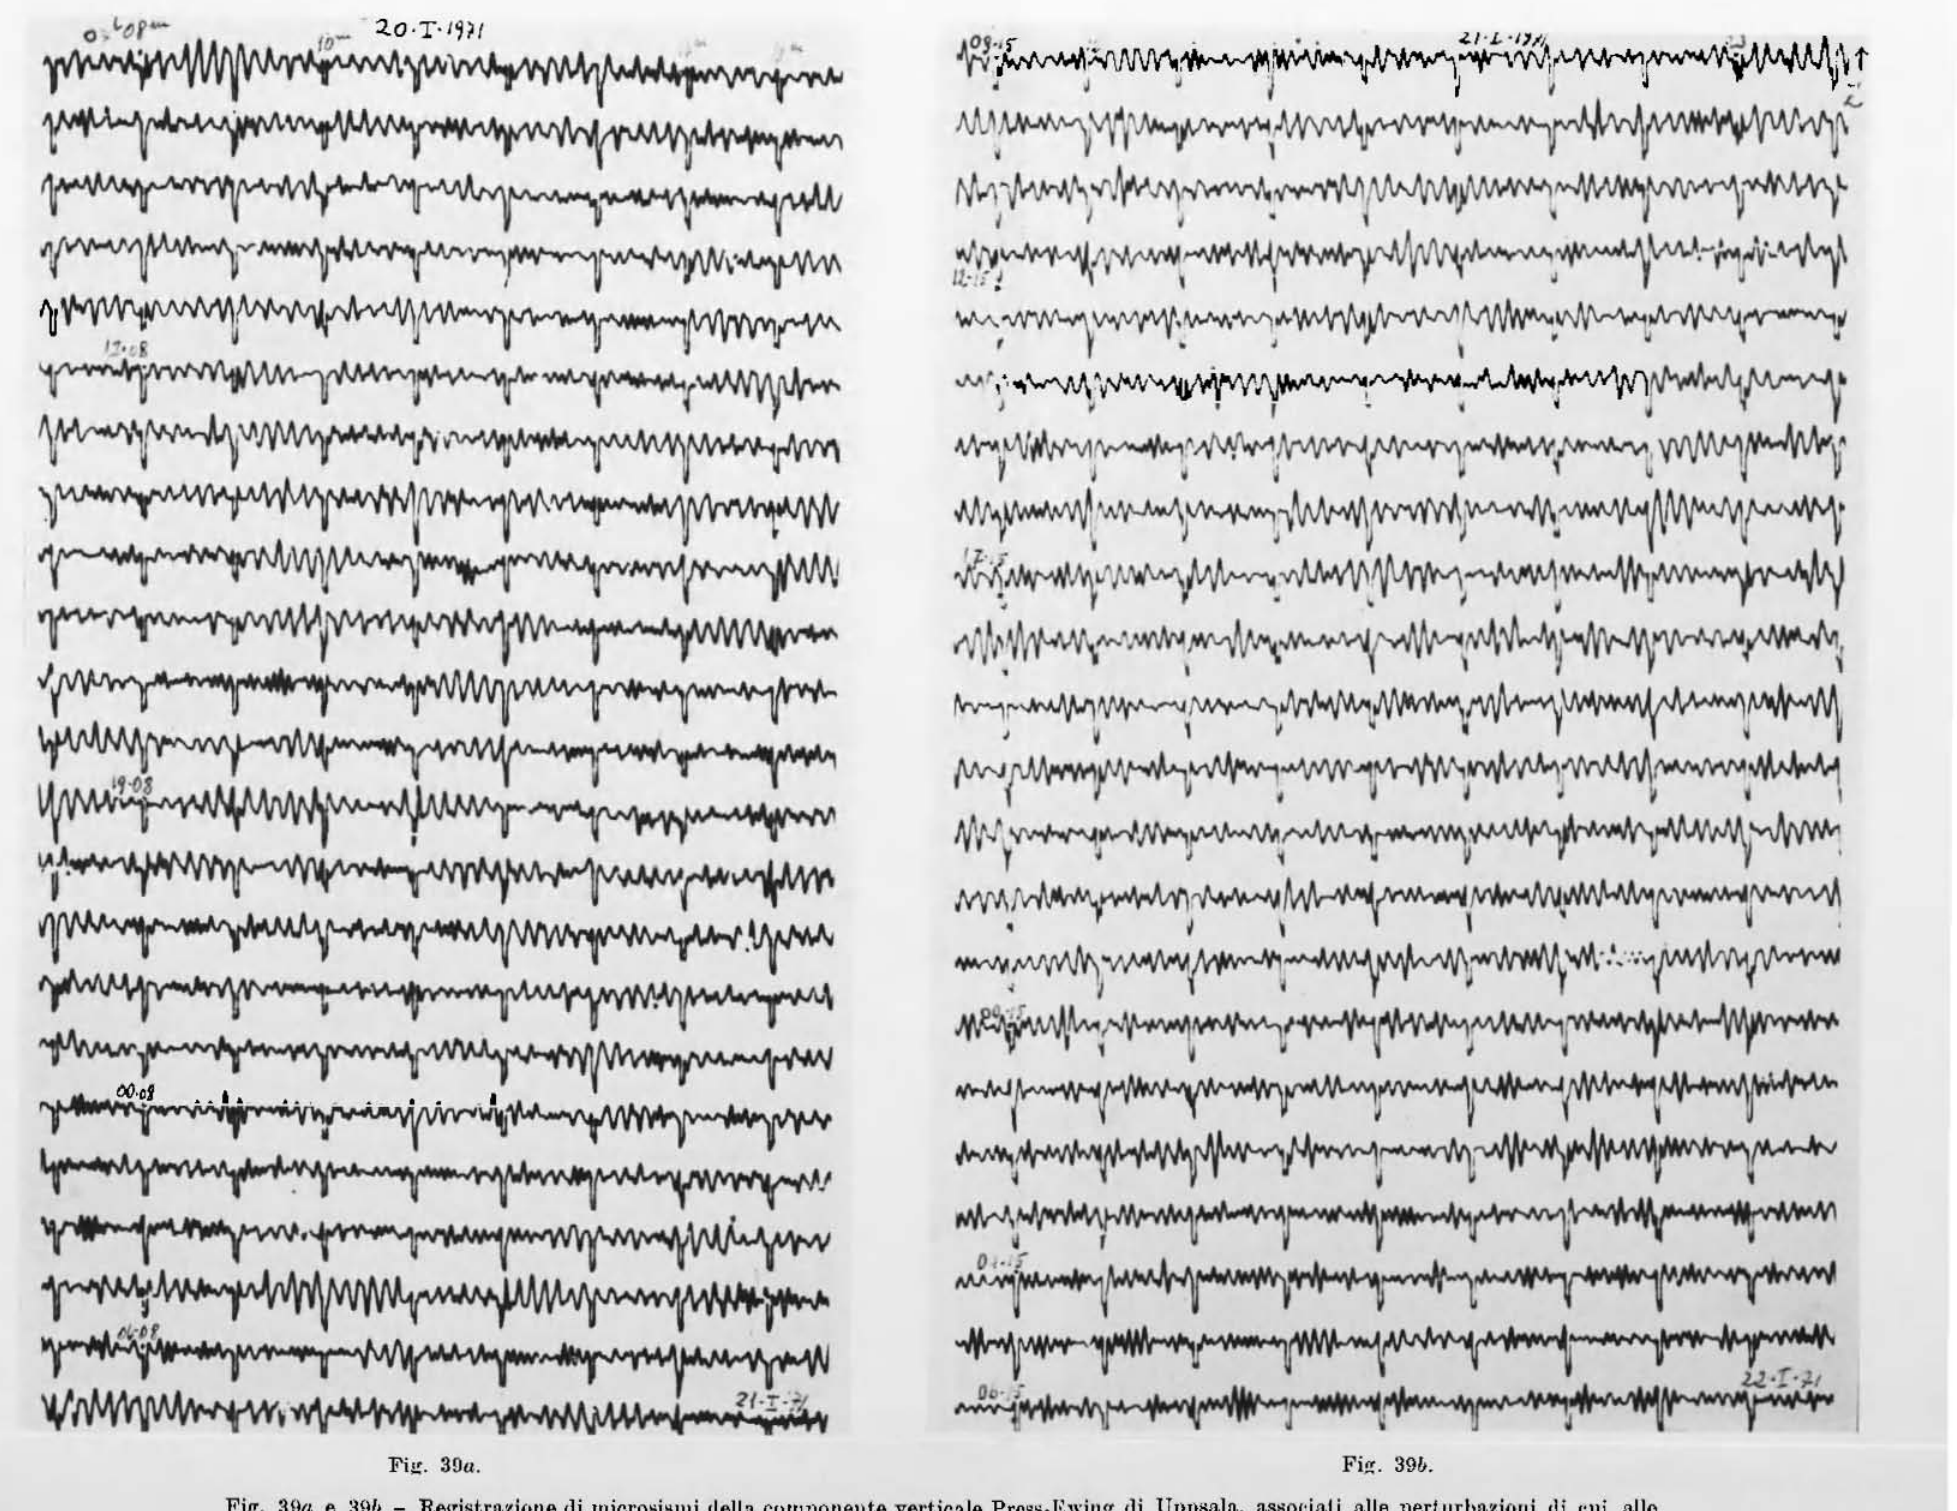
Fig. Sila e 3M! - Regh;tra~ione di mi('.ro"i~llIi rlella componente vertiea.le Prcss.Ewing di Upp;;ala, a..~~odali alle pertllrhazioni Ili {'ui allo figI;. 34·35. PrevalgOllo nettumellte i microRlsmi di 8-8,;'5 sec, propri della fascia atlantica ad OVellt Ilell'II'iRn,la. Ad inir.ilire cuI giofllo 22.1, 1071 col paMagl{io dellu perturlw.ziono noI lrIare ùel Noni, Il Uppsa.la i Jl\icro~isllli ,li 5,;'5 lIOO ea. - o, Fig. 3911 Illltl 39b - Rooor,ling of lIIicro~oilllllll the l'ertical ··Pre&ll.Ewing" cOIul>onent or U]ll»lal,~, n,sr<otiatecl lo tho perturbatioll IIhOViIl in figures 34 aliti